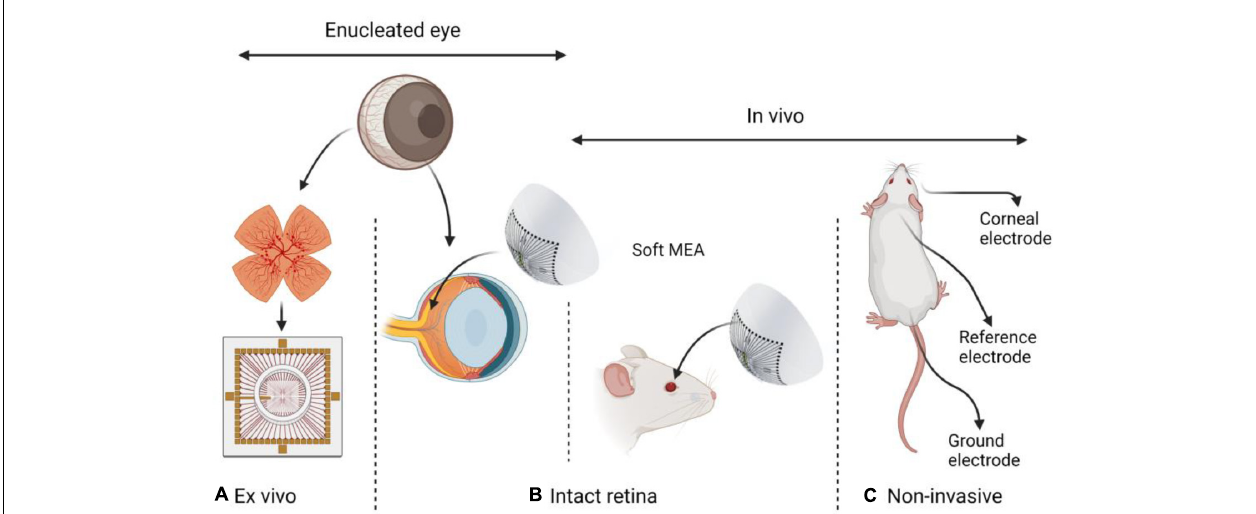
FIGURE 1 | Different approaches in retinal electrophysiology research: (A) Ex vivo – explanted retina. (B) Intact retina either in an enucleated eye or in vivo . (C) Non-invasive ERG in vivo . Common animal models include rabbits, rats, mice, chick embryos, and pigs. While ex vivo investigations require eye enucleation and are performed either with intact or explanted retina, in vivo investigations are performed on an intact retina in a living